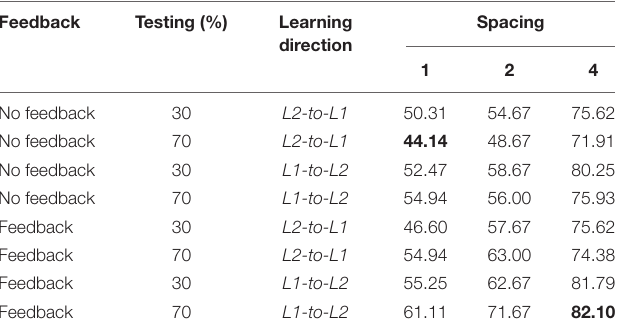
TABLE 2 | Proportions of correctly recalled word pairs in combinations of Spacing, Feedback, Testing, and Learning direction.